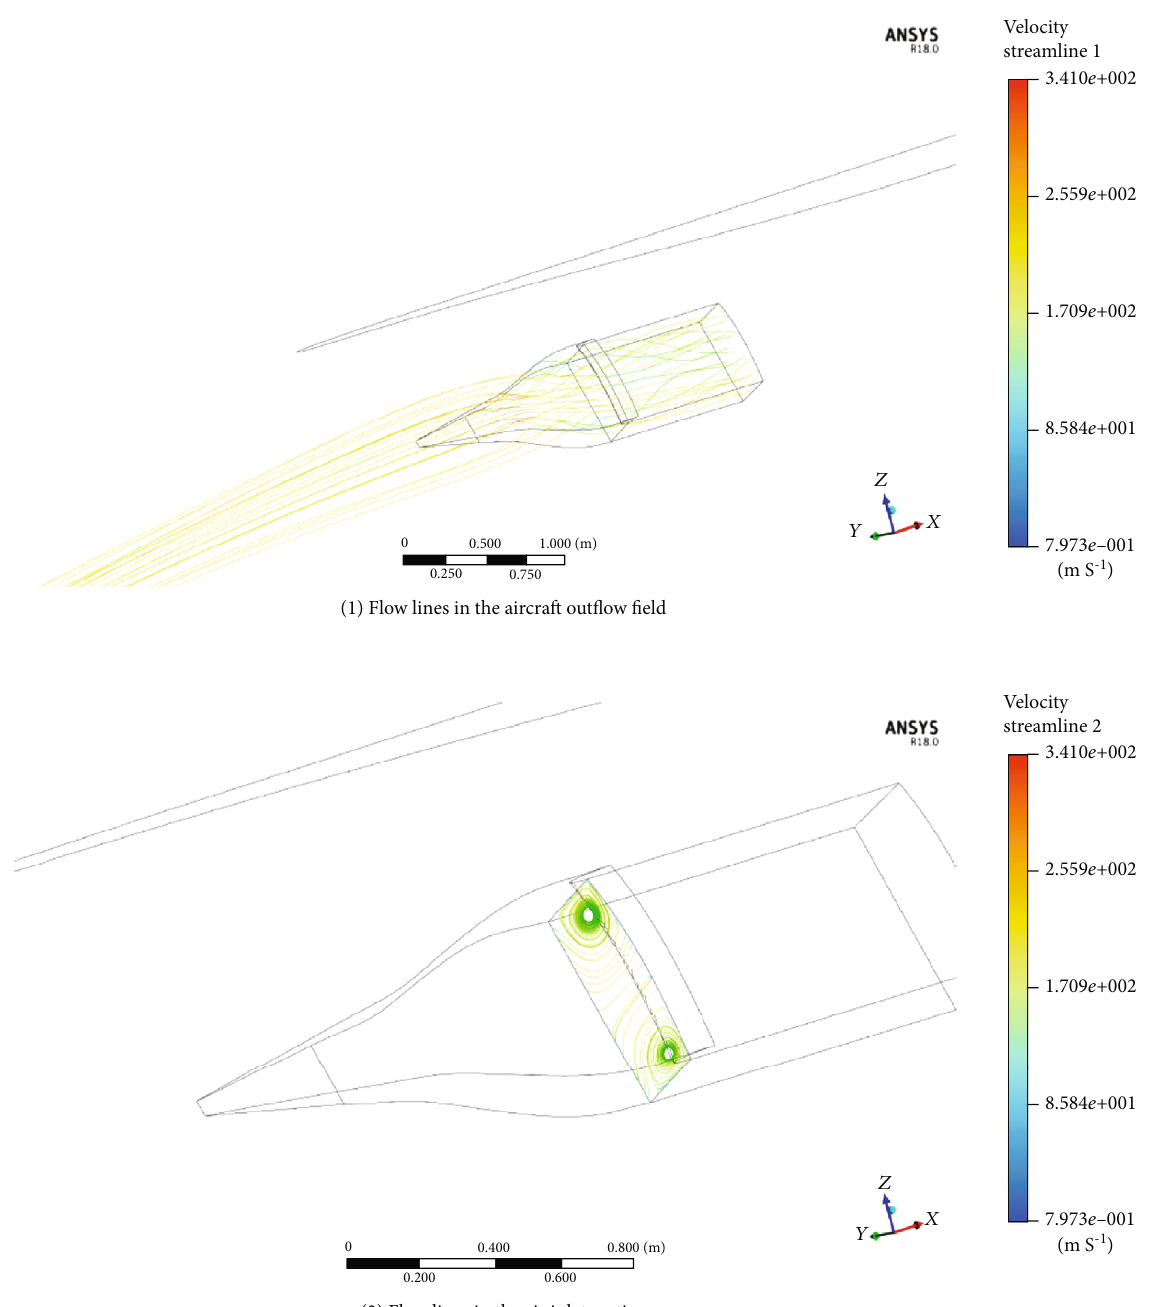
Figure 2: Velocity streamline of a NACA ram air inlet.